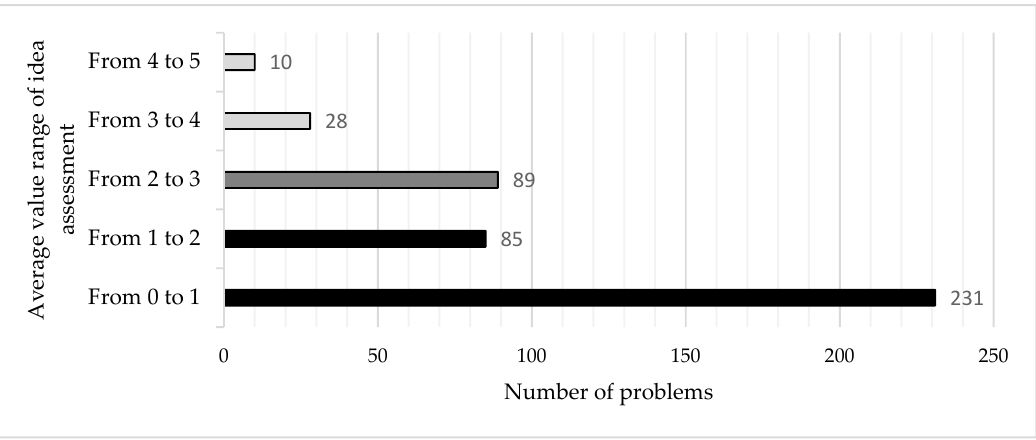
Figure 2. Distribution of the numbers of problems by the ranges of their average values.